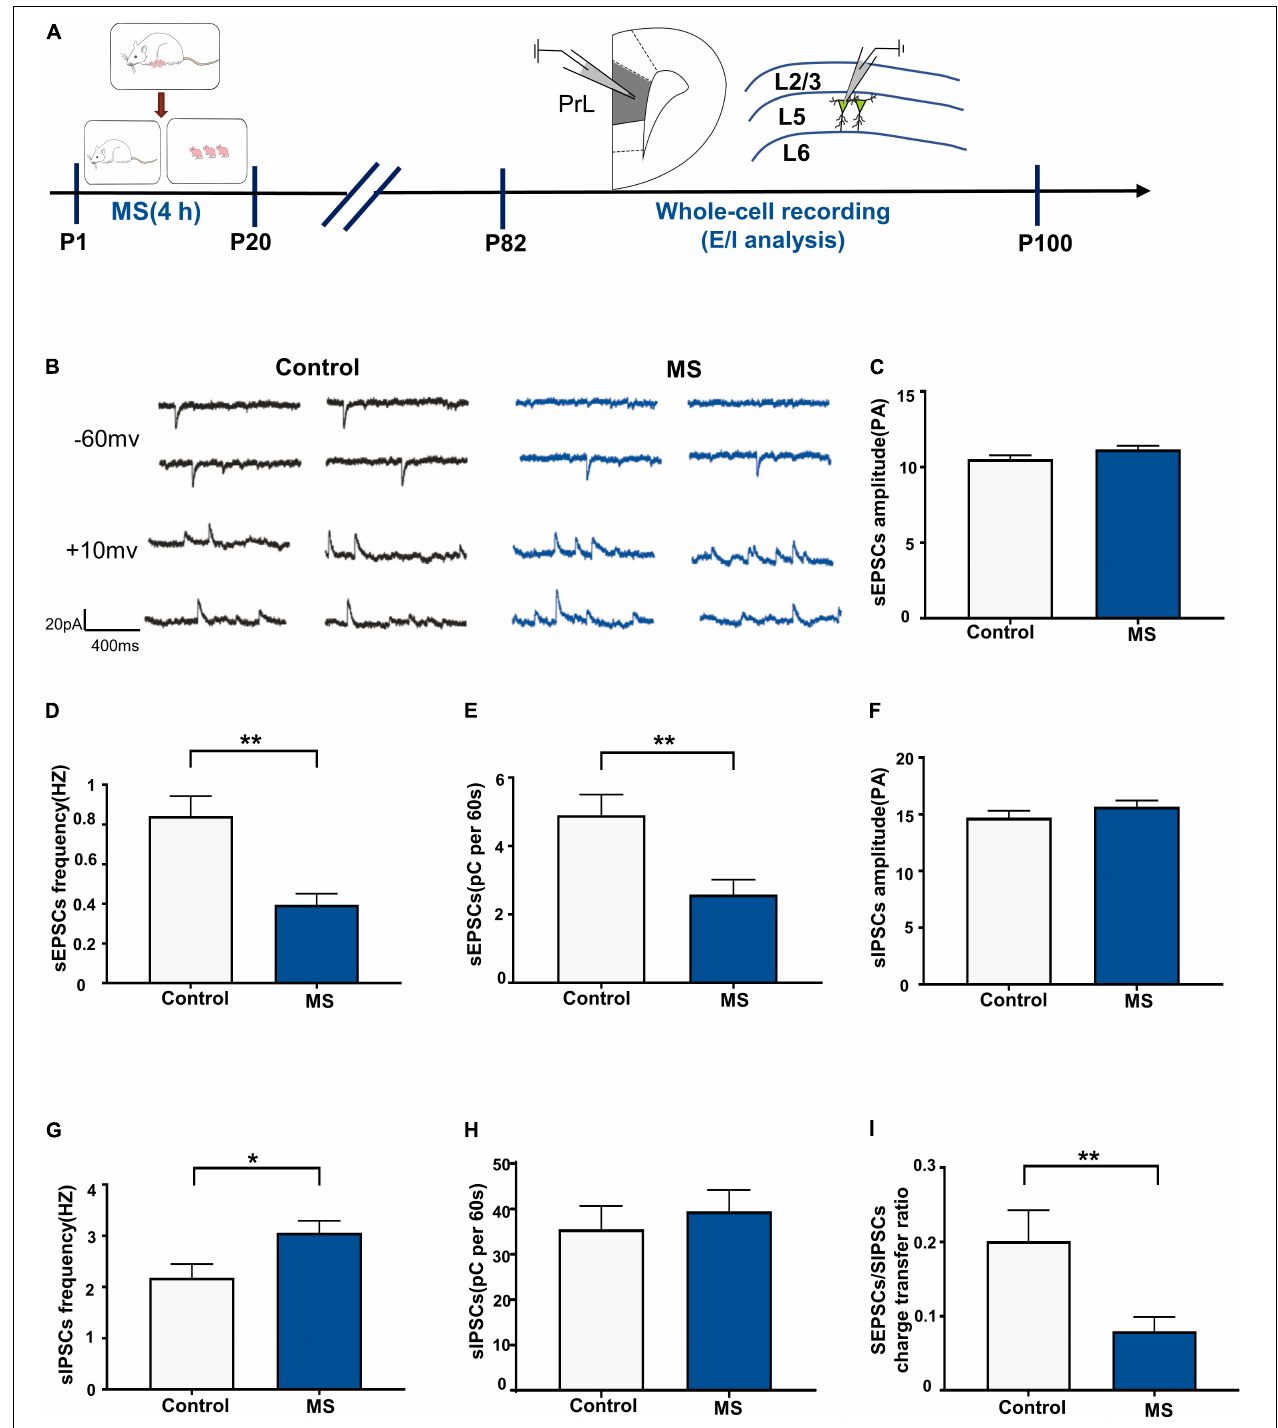
FIGURE 5 | Decreased E/I balance of L5 pyramidal cells in adult MS rats. (A) The experimental timeline of MS, whole-cell recording (E/I analysis). (B) Representative sEPSC (upper) and sIPSC (lower) current traces at a holding potentiation of –60 and +10 mV, respectively. Scale bars: 20 pA, 400 ms. (C–E) Changes in the amplitude, frequency, and quantification of sEPSC current recorded by isolated patch clamp in adult rats. (F–H) Changes in the amplitude, frequency, and quantification of sIPSC current recorded by isolated patch clamp in adult rats. (I) sEPSC/sIPSC charge transfer ratios. * p < 0.05, ** P < 0.01. Data are the means ± SEM ( n = 14–15 cells from 3 to 4 rats each